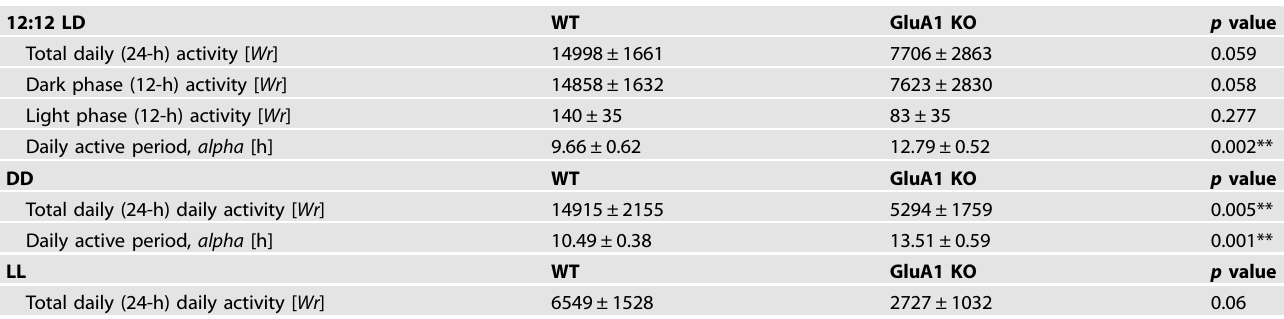
Table 2. Additional circadian parameters of GluA1 knockouts assessed under running wheels.